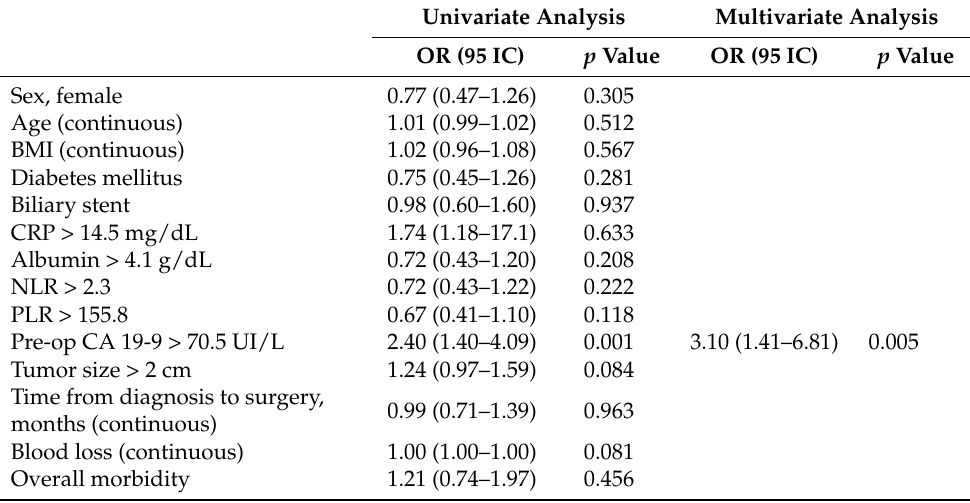
Table 5. Univariate and multivariate analysis of predictive factors of early